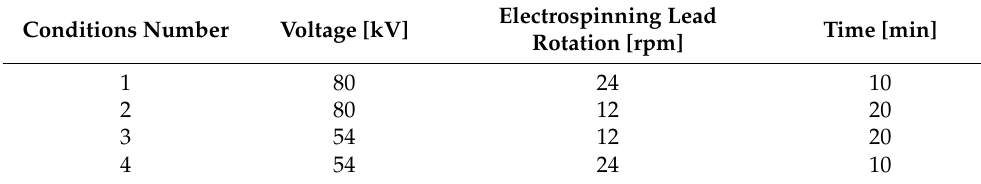
Table 2. Process parameters for electrospinning of PLA membranes. Conditions